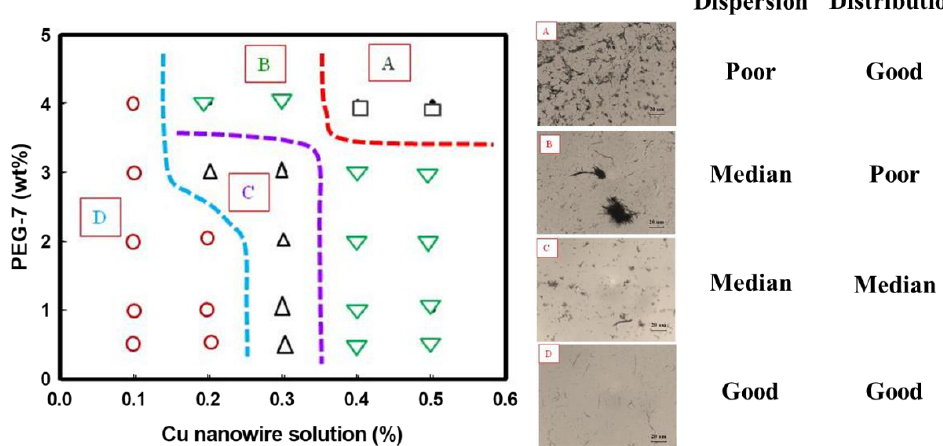
Figure 5. The phase behavior window for CuNWs/PEG-7/Water.